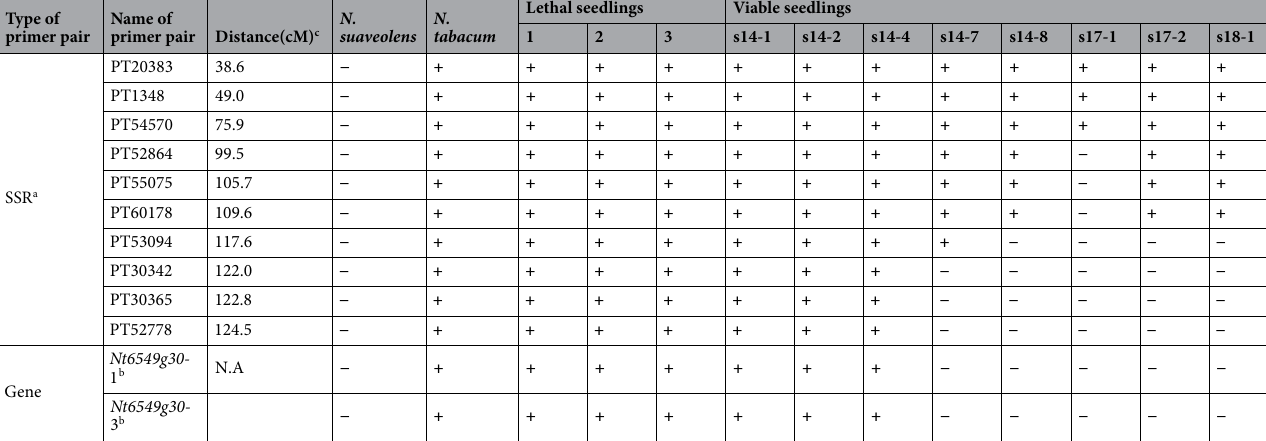
Table 1. Detection of products, amplified by SSR and Nt6549g30 primer pairs, from the Q chromosome (Linkage group No. 11) of N. tabacum in lethal seedlings, viable seedlings, and viable regenerated plants of the N. suaveolens × N. tabacum cross. ‘ + ’ indicates the presence of allele of N. tabacum, ‘-’ indicates the absence of allele of N. tabacum. N.A., not applicable. a Bindler et al. 43 , 44 . b Closely linked to PT30342, as confirmed by linkage analysis (Ma 12 ). c Genetic distance from the marker amplified by primer pair